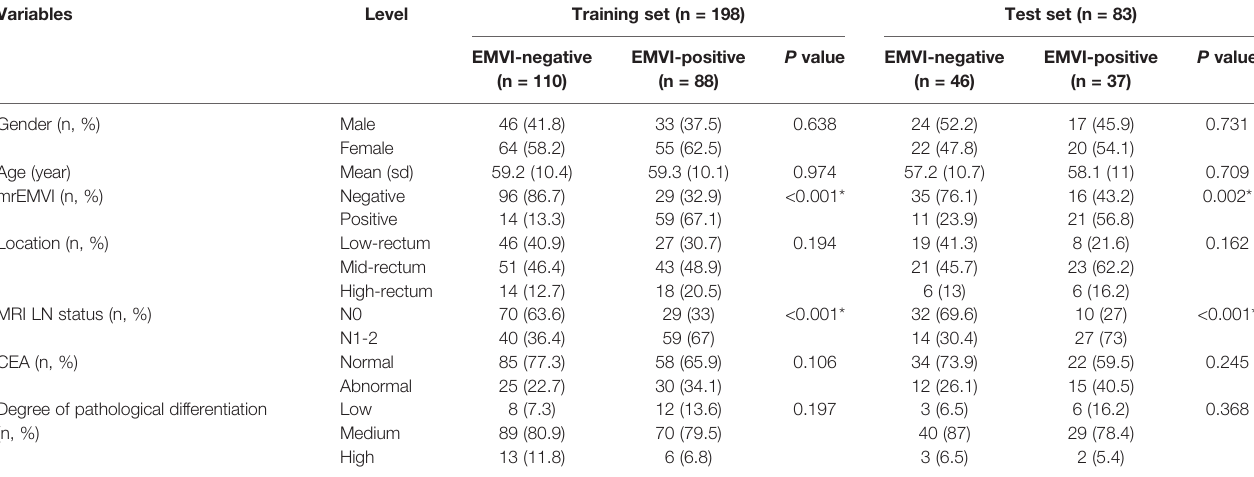
TABLE 2 | Clinical characteristics of the training and test sets. Variables